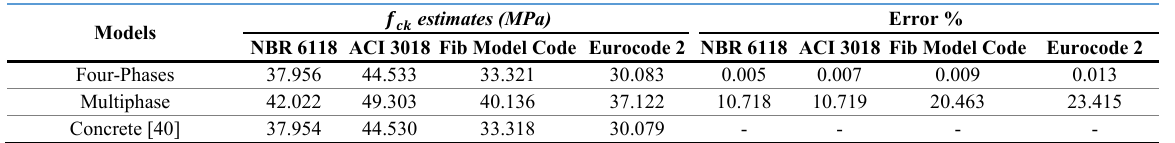
estimated using empirical models and homogenization (Level 𝑓𝑓 𝑐𝑐𝑐𝑐